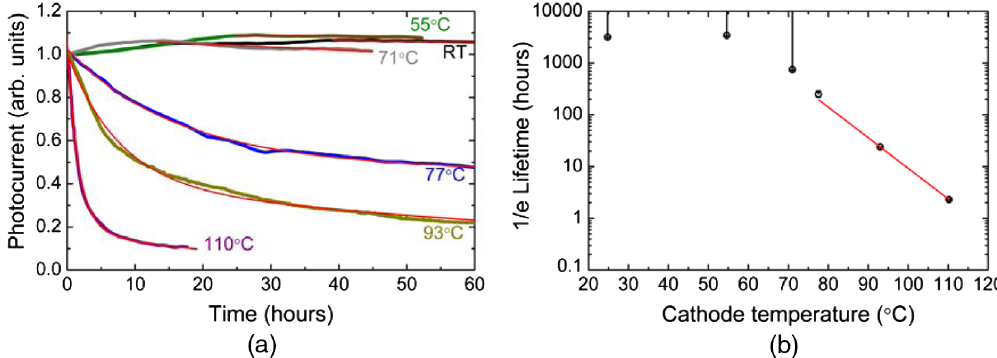
FIG. 3. (a) Decay curves of a series of K-Cs-Sb photocathodes at different temperature. The photocurrent was monitored by illuminating the cathode surface with a 532-nm laser. (b) 1 = e lifetime of photocathodes as a function of different decay temperature. Due to the very large decay constants below 71 °C we indicate the 1 = e lifetimes below these temperatures as the lower bounds for the lifetime. All other error bars of the estimated lifetime values that are calculated based on the 95% confident bounds of the fitted decay constants and amplitudes are within 10%, therefore smaller than the points. The red line is an exponential fit of 1 = e lifetime data of 77 °C, 93 °C and 110